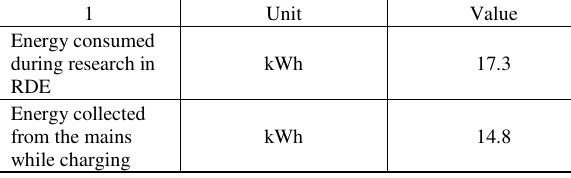
Table 3. The average energy consumption of the EV vehicle and the average energy taken from the electricity grid during its